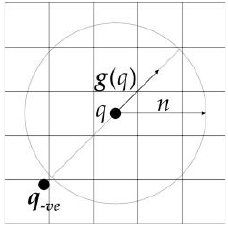
Figure 8. Schematic map of the negatively affected pixel. At each radius n , an orientation projection image O n and a magnitude projection image M n are formed. For each affected pixel, the corresponding point q − ve in the orientation projection image O n and magnitude projection image M n is decremented by 1 and || g ( q )||